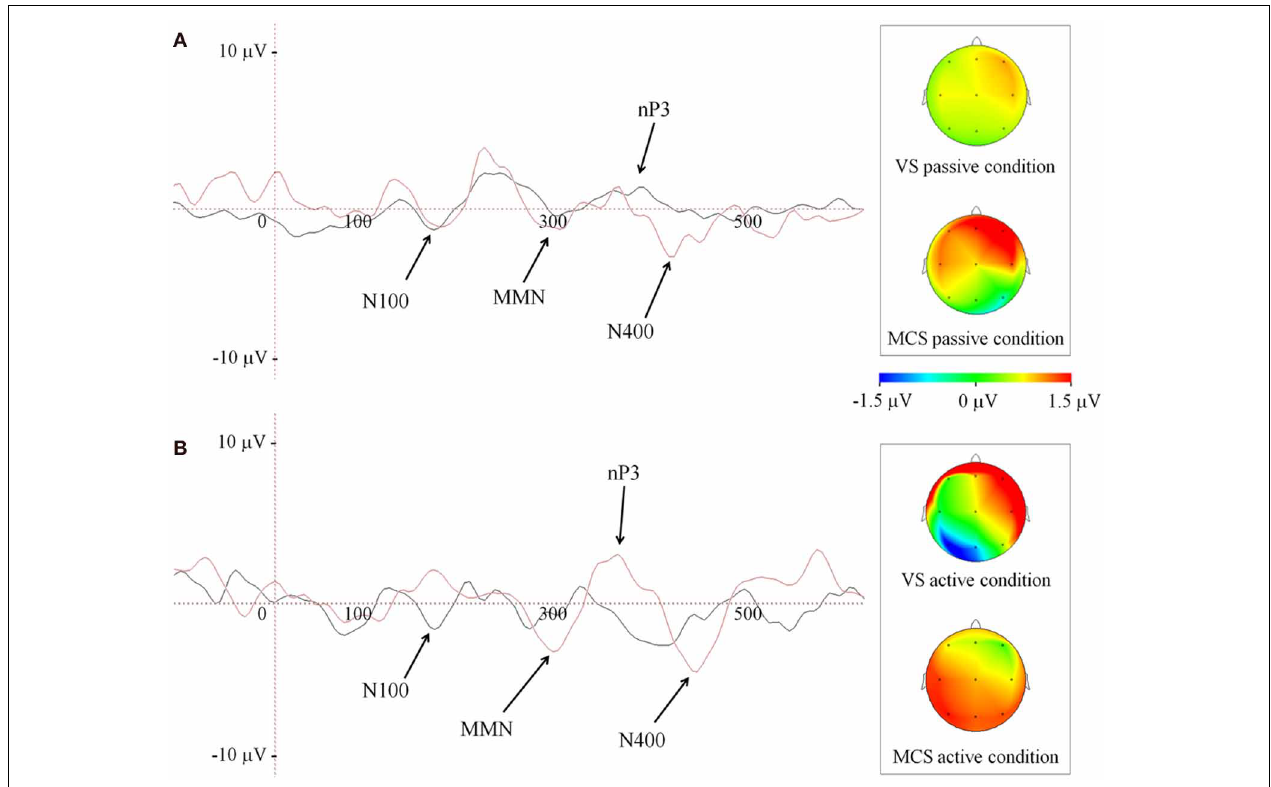
FIGURE 2 | Grand average of ERP waveforms depicted at Cz during passive (A) and active (B) listening of patients’ own name (novel stimulus), in both group of patients. Black and red traces code for VS and